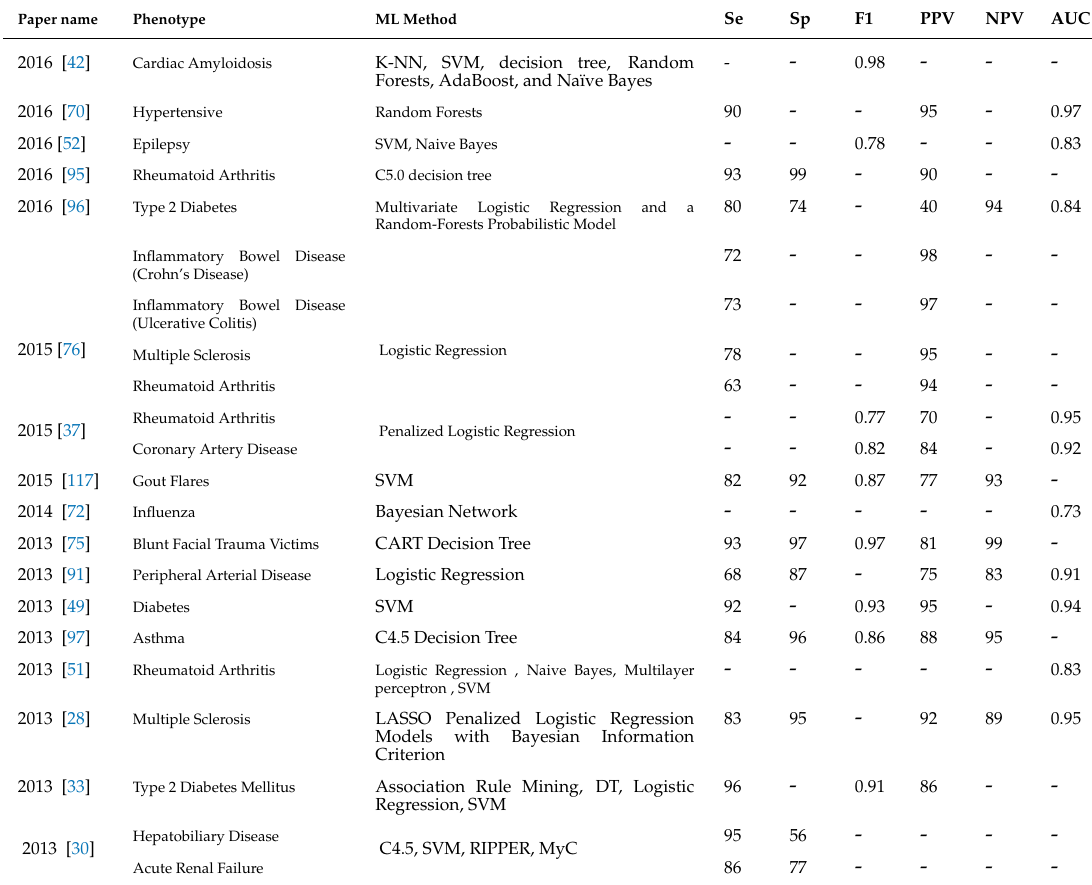
Table 4. List of studies using supervised learning as a classification